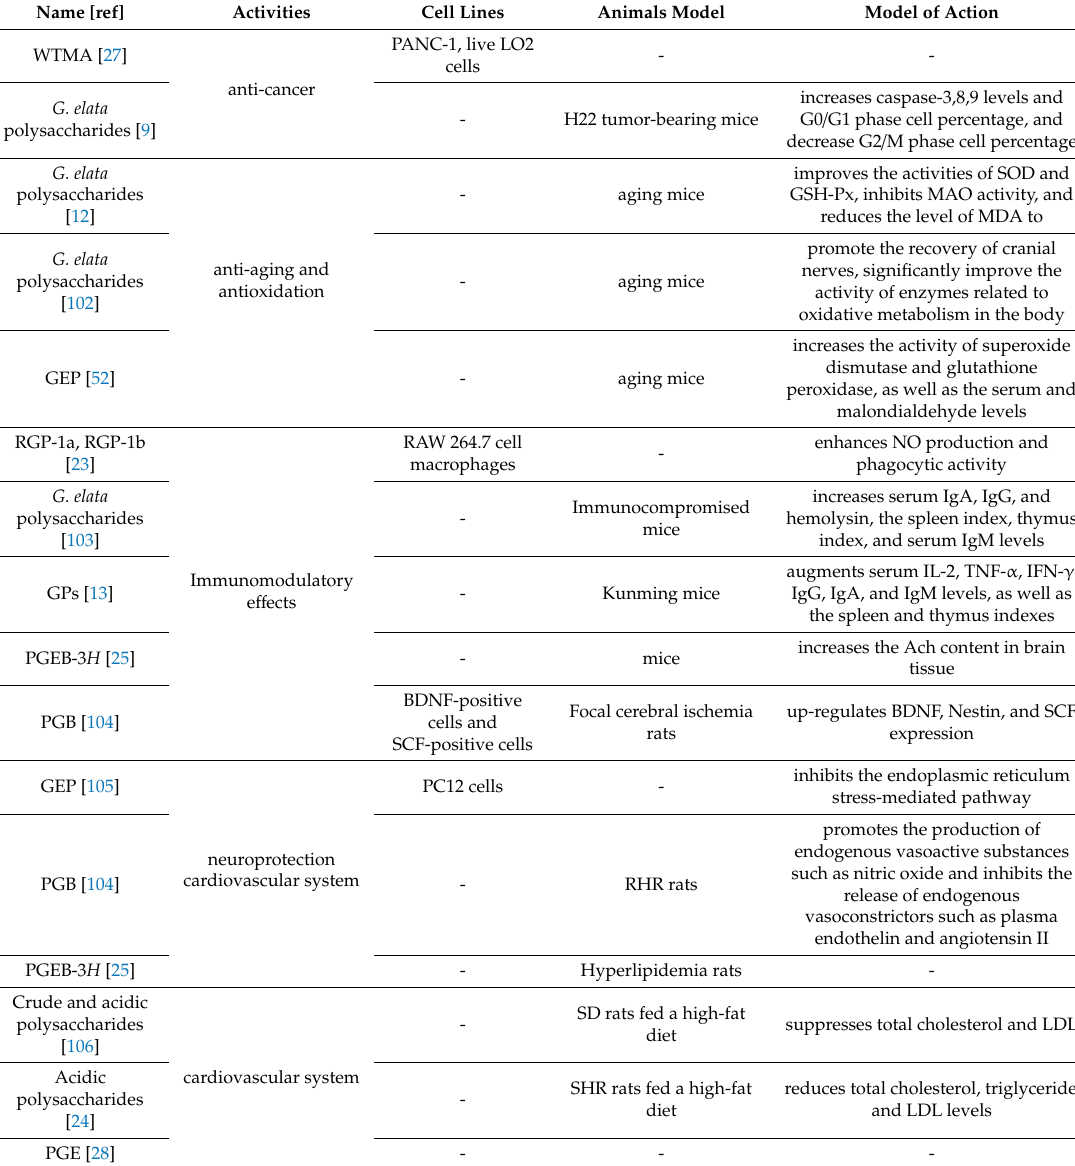
Table 5. Pharmacological activities information about polysaccharides isolated from G. elata